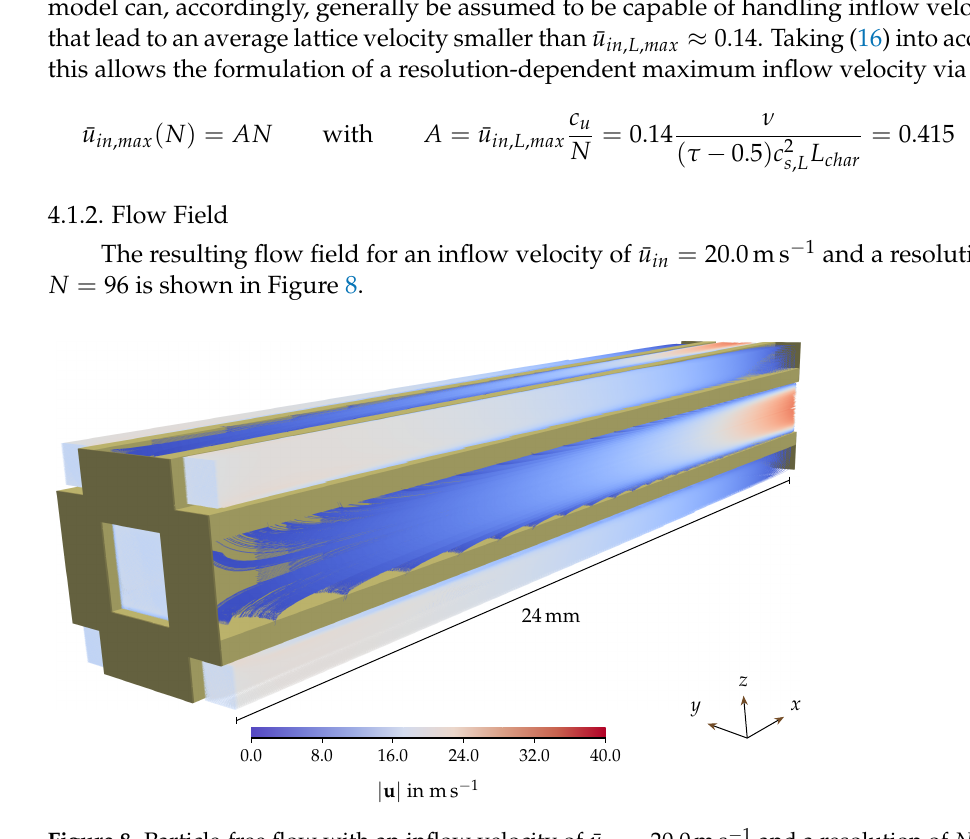
Figure 8. Particle-free flow with an inflow velocity of ¯ u in = 20.0ms − 1 and a resolution of N = 96. Dark yellow structures represent porous filter substrate, brown structures solid walls. Streamlines exhibit local flow direction. Colour scale indicates local velocity